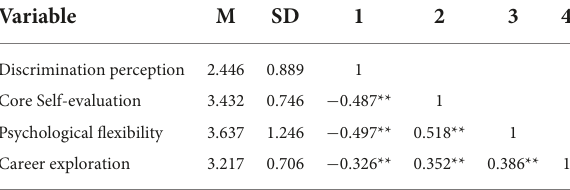
TABLE 1 Means, standard deviations, and